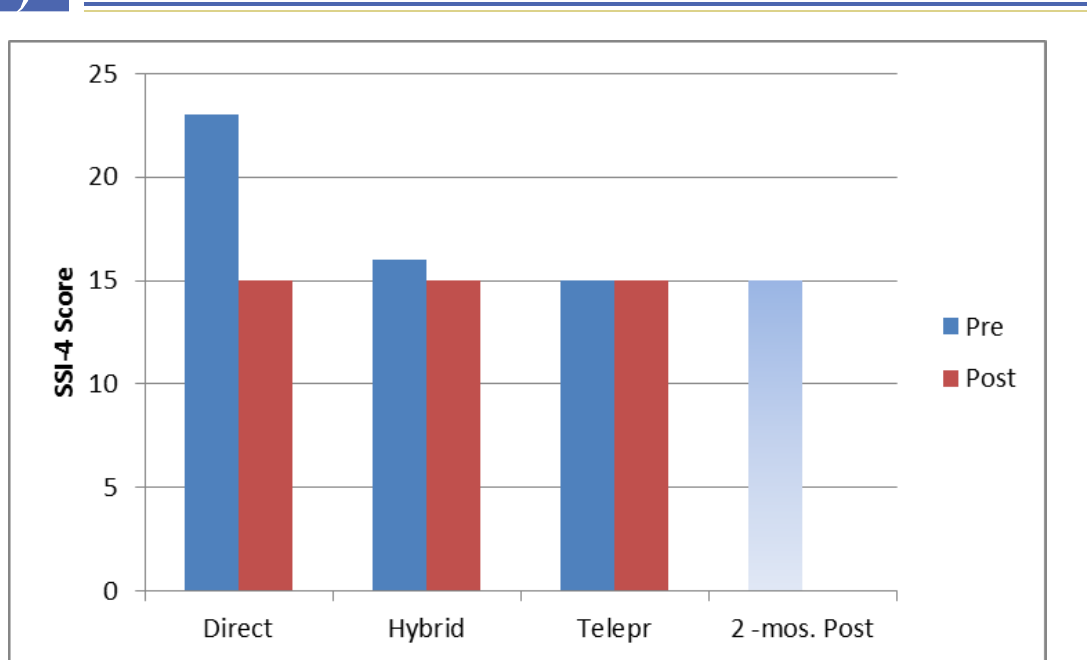
Figure 1. Participant 1 scores from Stuttering Severity Instrument-4 (SSI-4) across service delivery models (Telepr=Telepractice).